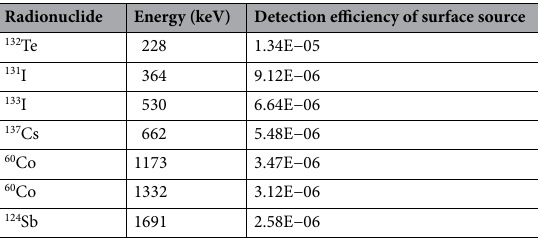
Table 4. Detection efficiency of uniformly distributed large area